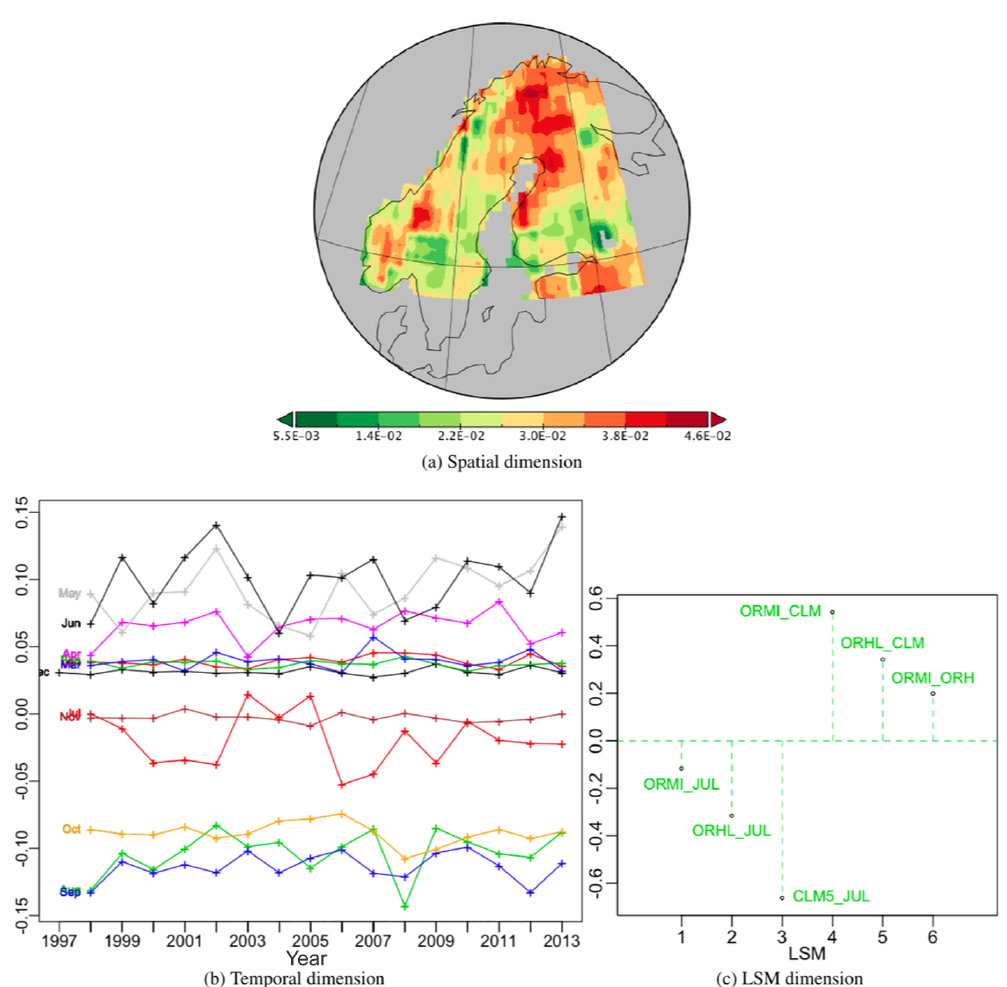
Figure 10. Second best PT ( vs222 ) of the PTA3 decomposition of the six normalized differences, representing 21.7% of the variability.